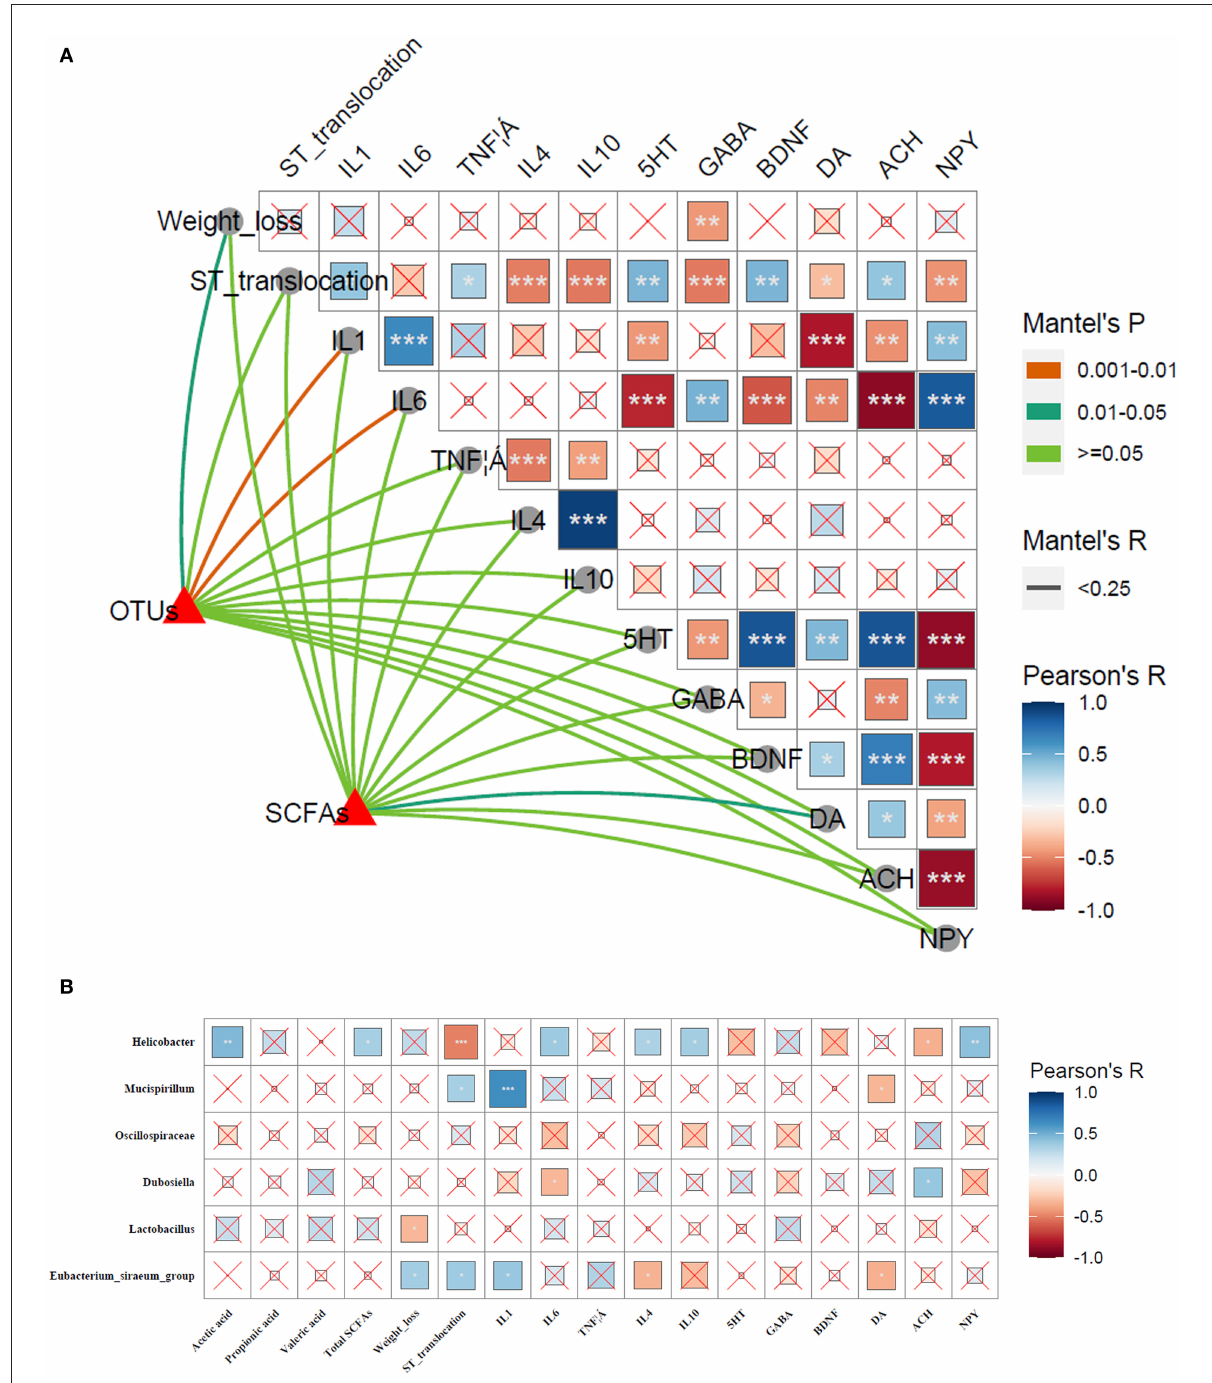
FIGURE13 Correlations between phenotypic variables and microbial communities. (A) The relationship between phenotypic variables and microbial communities. The Pearson correlation coefficient denotes Pairwise comparisons of phenotypic variables with a color gradient. Taxonomic structures and SCFAs were linked to each phenotypic variable by Mantel correlation based on Bray–Curtis dissimilarity. The line thickness indicates the Mantel’s R statistic for the corresponding distance correlations, and the color indicates statistical significance. * p < 0.05; ** p < 0.01; *** p < 0.001. (B) Pearson’s correlation analysis. Correlations of phenotypic variables (SCFAs, weight loss, ST translocation in brain, inflammatory cytokines, and neuroactive molecules) and microbial communities. The color and the dot size represent the